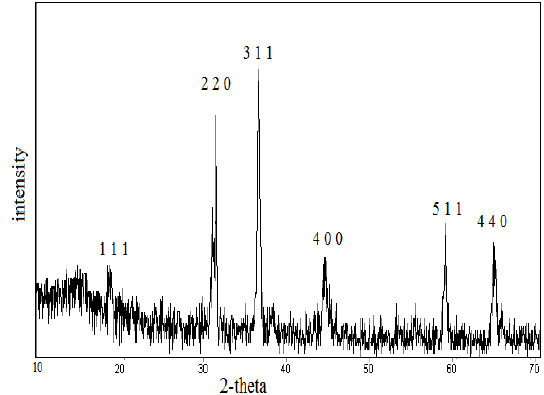
Fig. 7. XRD patterns of Co O prepared after 3 4 calcination of compound 1